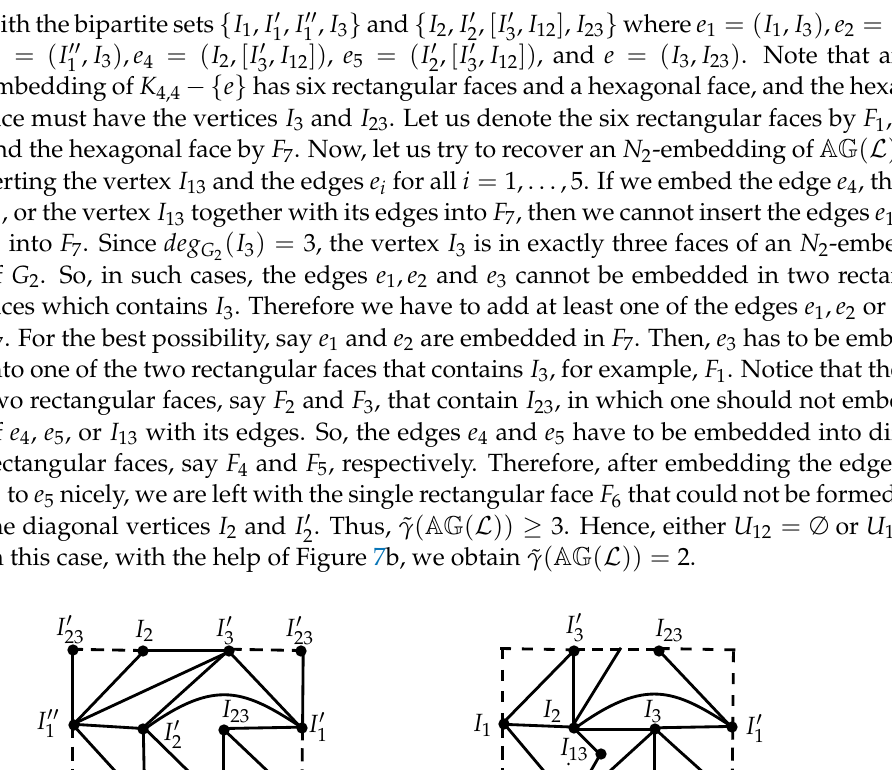
∪ ∪ 3 3 U n | = 7 with | U 1 | = 3 and | U 2 | = 2.. Figure 7. | U n | = 7 with | U 1 | = 3 and | U 2 | = n = 1 n = 1